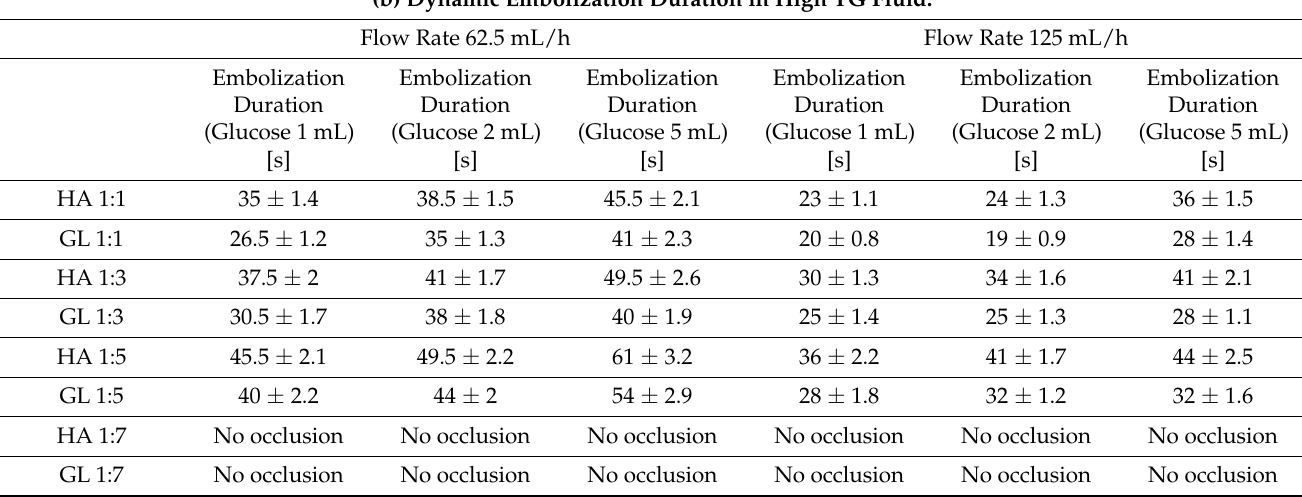
Table 1. Cont. (b) Dynamic Embolization Duration in High TG Fluid.